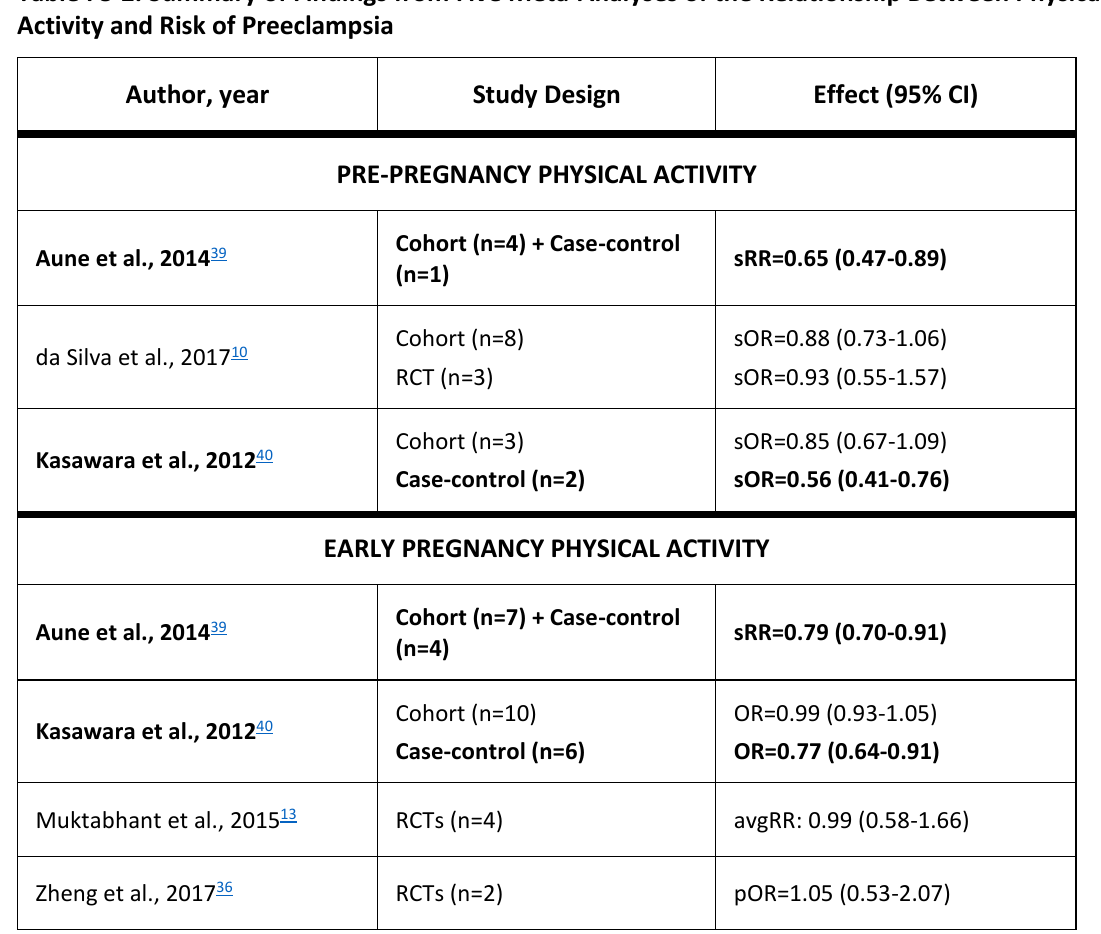
Table F8-2. Summary of Findings from Five Meta-Analyses of the Relationship Between